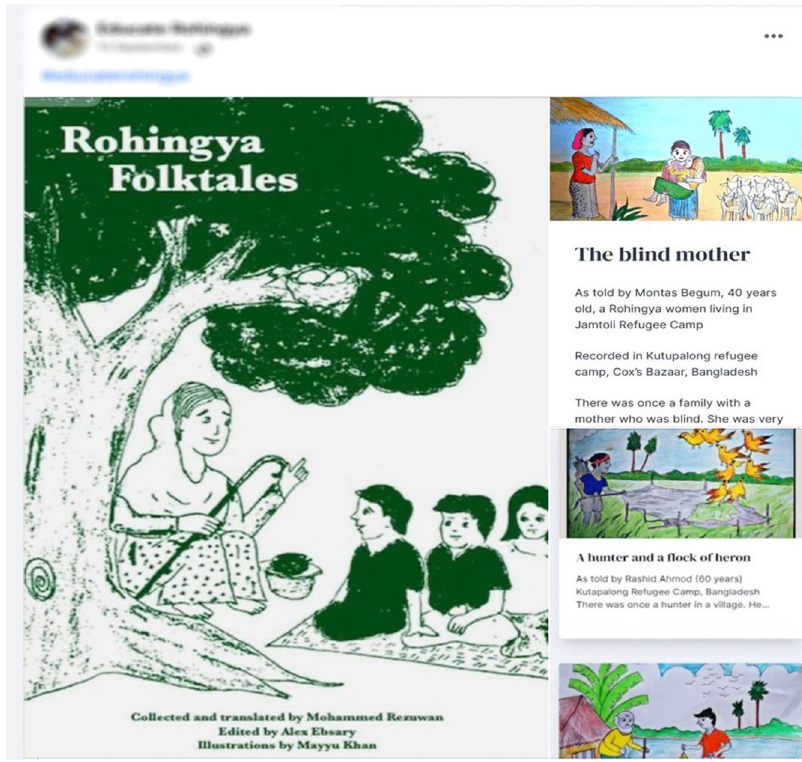
Fig. 5 Online collection of translated Rohingya folktales. Dissemination of Rohingya folklore online via Facebook.